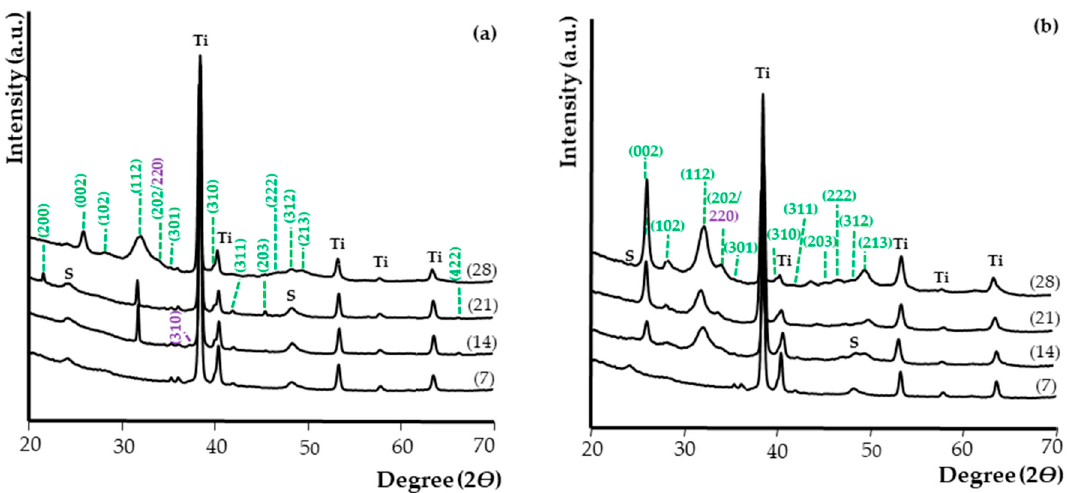
Figure 9. X-ray diffraction patterns of T-S/Ca (7) and T-S/HA (14–28) ( a ) and T5-S/Ca (7) and T5-S/HA (14–28) ( b ) samples after immersion in SBF solution for 7, 14, 21, and 28 days. ( hkl ) for HA are marked in green, while ( hkl ) for CaTiO 3 are marked in violet. Ti was assigned to the Ti6Al4V substrate; S was assigned to the sodium